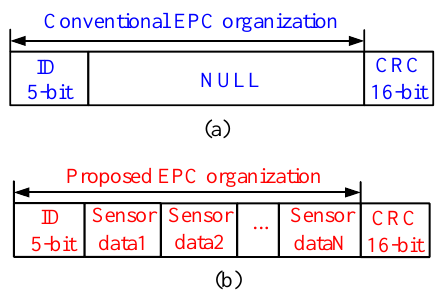
Figure 2. EPC area coding scheme of RF Tag chip: ( a ) conventional organization strategy; ( b ) proposed organization strategy.